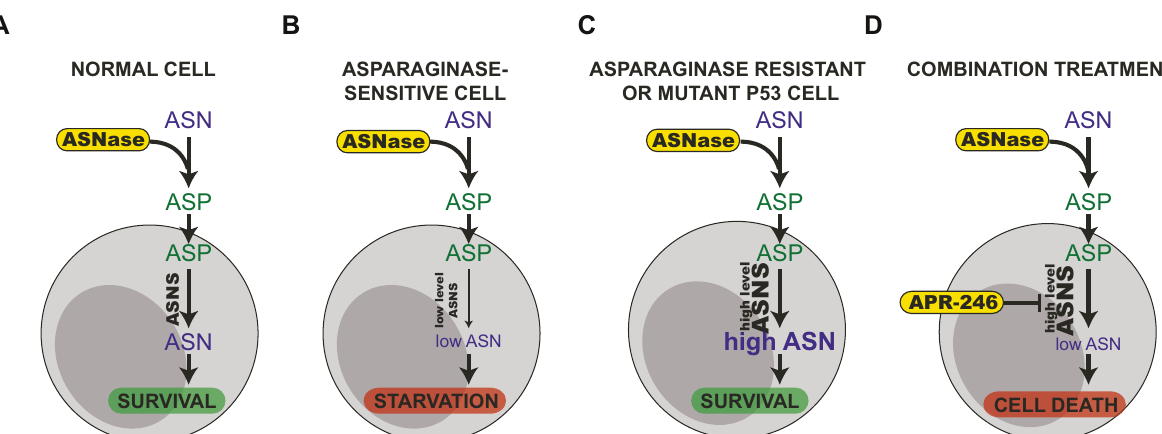
Fig. 5 Proposed mechanisms of synergy between APR-246 and ASNase. A Asparaginase (ASNase) depletes extracellular asparagine (ASN) by converting it to aspartic acid (ASP). Normal cells can synthesize ASN by asparagine synthetase (ASNS). B Acute lymphoblastic leukemia (ALL) cells have defective ASNS expression and are therefore sensitive to ASNase treatment. C ASNase resistance is associated with ASNS expression and the resistant cells can therefore synthesize ASN from ASP. D Combination treatment with mutant p53 reactivating compound APR-246 directly or indirectly inhibits ASNS, resulting in enhanced sensitivity in ASNase-resistant ALL